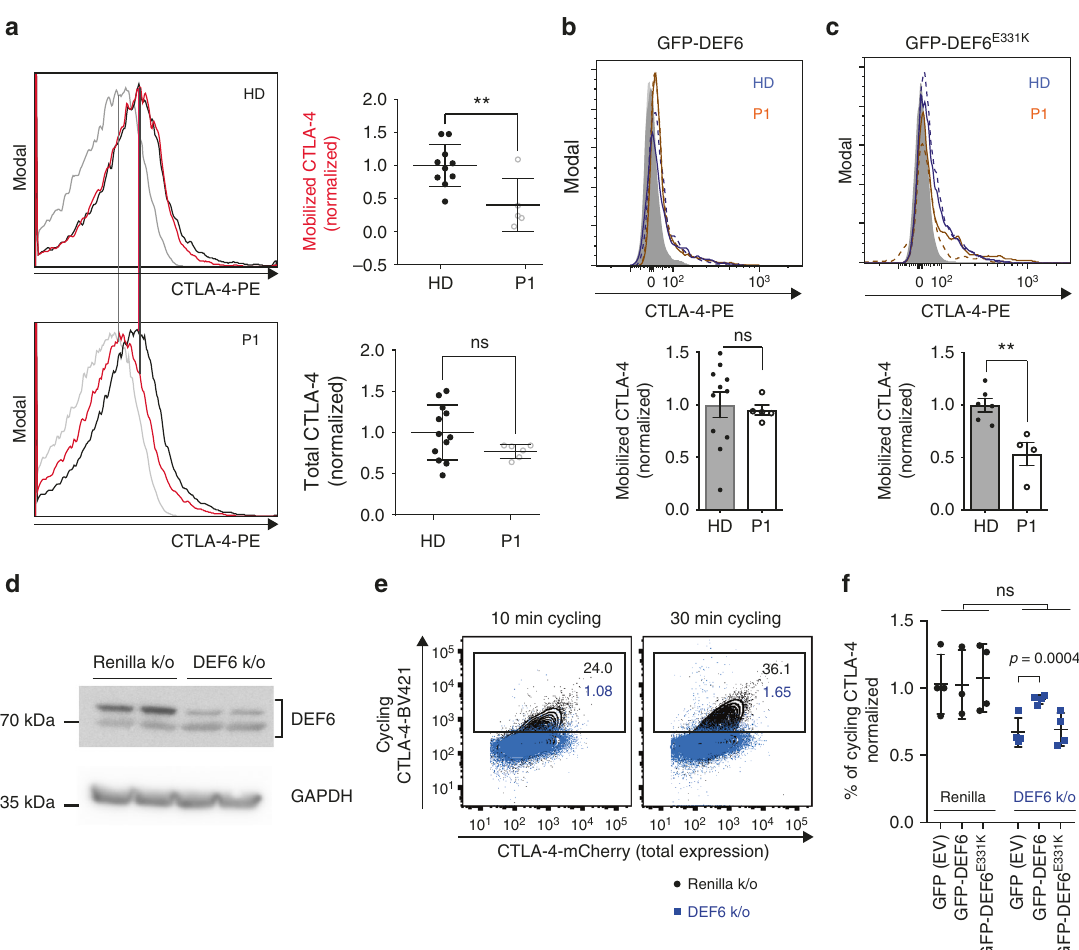
Fig. 5 Defective CTLA-4 traf fi cking is rescuable and recapitulated by Jurkat DEF6 knockouts. a Short-term mobilization of CTLA-4 is reduced in P1 T cells (bottom), compared to healthy control (HD, top). Cells were stimulated for 1 h with PMA/ionomycin. CTLA-4 antibody was present during stimulation to capture surface CTLA-4. Black – total CTLA-4, red – mobilized CTLA-4, gray – background surface stain. Statistics: ** p = 0.0079, n.s. p = 0.1261 (Unpaired t test). Data are overlaid with mean ± SD. Two biological replicates. b, c Wild type but not mutant DEF6 rescues CTLA-4 mobilization defects in P1 cells. PBMCs were electroporated with either GFP-DEF6 ( b ) or with GFP-DEF6 E331K ( c ) and stimulated as in ( a ) (top: representative plots, blue: healthy control; orange: patient; dashed line: mobilized CTLA-4; straight line: total CTLA-4; bottom: quanti fi cation; Statistics: p = 0.7807 and p = 0.0043, unpaired t test). Data are overlaid with mean ± SD. Representative of two independent experiments. Gating as in Fig. S4a. d Immunoblot of CRISPR-mediated DEF6 knockout and Renilla control, in Jurkat cells transduced with mCherry-CTLA-4. Images were cropped for visualization, an additional GAPDH blot is shown in